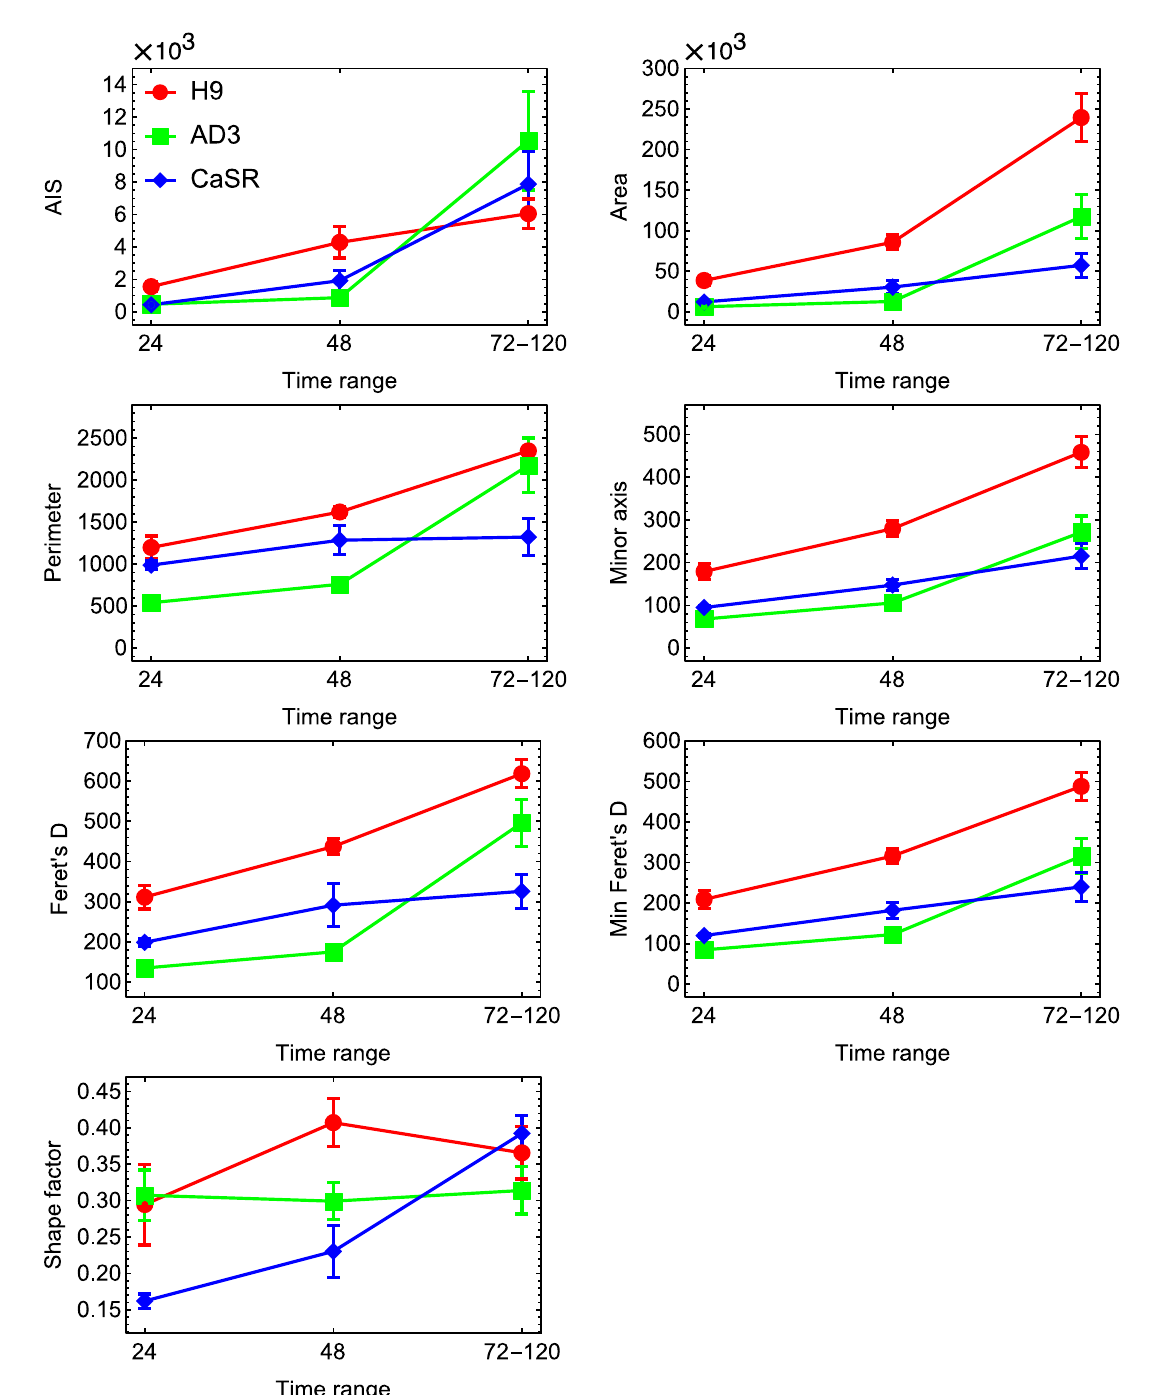
Figure 3. Dynamics of morphological parameters for colonies from three cell lines. The values of seven parameters from Table 1 were measured for all colonies from H9 (red), hiPSC AD3 (green), and hiPSC CaSR (blue) lines and all passages, at 24 h, 48 h, and 72–120 h. Mean values across processed colonies at each time point are shown, with the standard errors of the mean (SEMs) as the error bars. Late time points are grouped into one range. Shape factor, dimensionless parameter; AIS and Area, μ m 2 ; all other parameters, μ m.